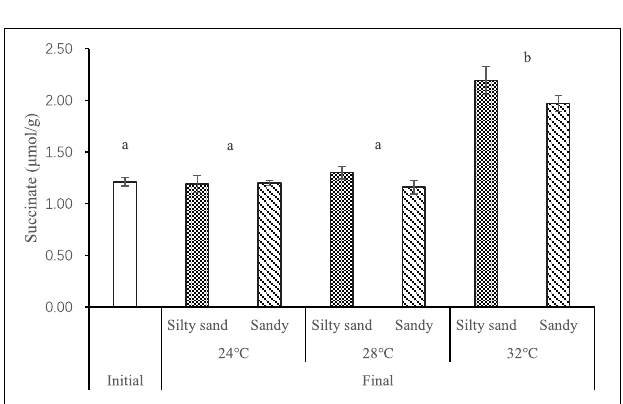
FIGURE 4 | Concentrations of succinate in Manila clam soft tissue at different temperatures and in different sediment types. The different letters indicate significant difference of succinate at different